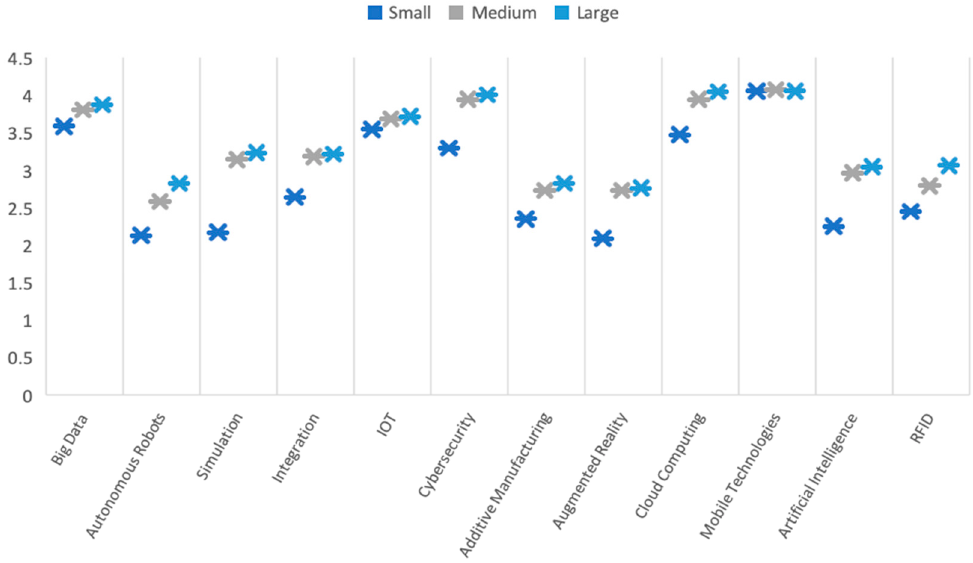
Figure 8. Industry 4.0 technologies (scatter chart).